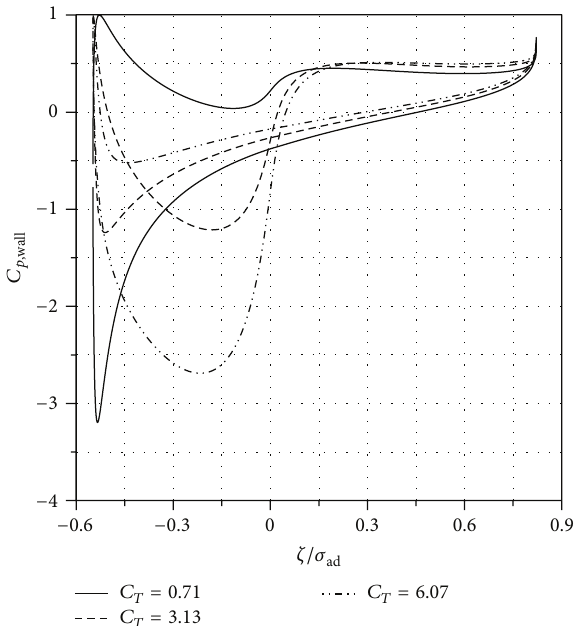
Figure 11: Wall pressure coefficient distribution along the duct NACA